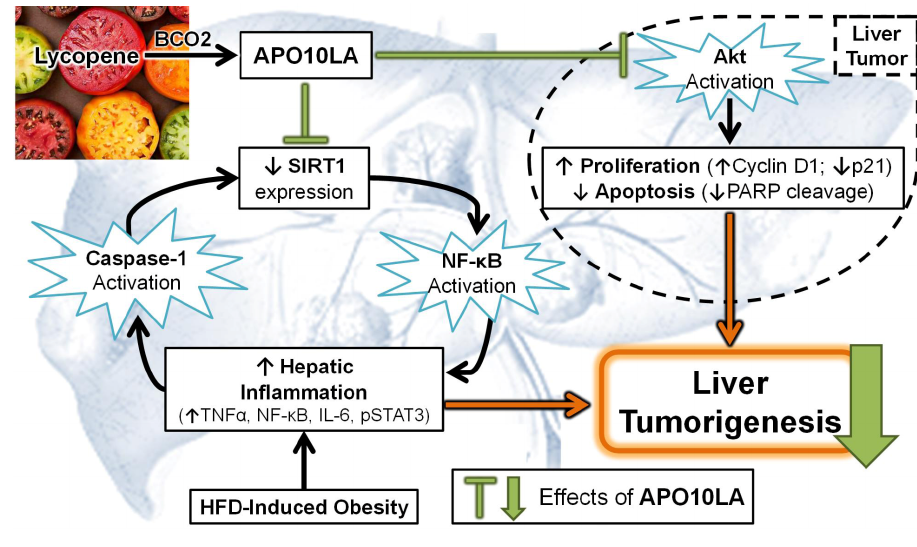
Figure 4 . Schematic diagram of potential mechanisms by which apo-10 ′ -lycopenol acid (APO10LA) inhibits high-fat diet (HFD)-promoted hepatic inflammation and tumorigenesis. Lycopene is endogenously metabolized to APO10LA by BCO2. APO10LA inhibits HFD-induced hepatic inflammation and tumorigenesis, through interrupting the vicious cycle of HFD-promoted up-regulation of nuclear factor- κ B (NF- κ B) signaling, escalation in inflammasome function and reduction in sirtuin 1 (SIRT1) signaling. APO10LA reduced HFD-promoted hepatic tumor number and volume by inhibiting Akt activation in liver tumors. IL, interleukin; PARP, poly ADP ribose polymerase; STAT3, signal transducer and activator of transcription 3; TNF α , tumor necrosis factor